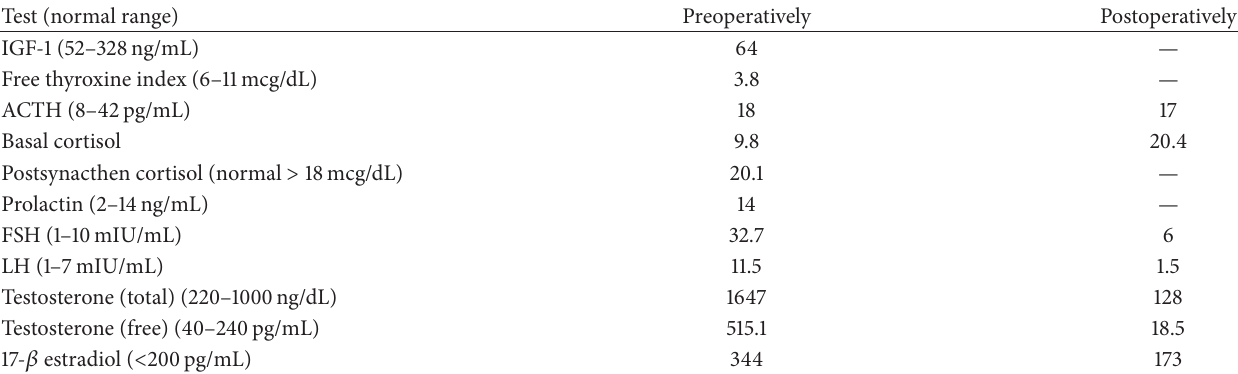
Table 1: Preoperative and postoperative laboratory blood tests in the